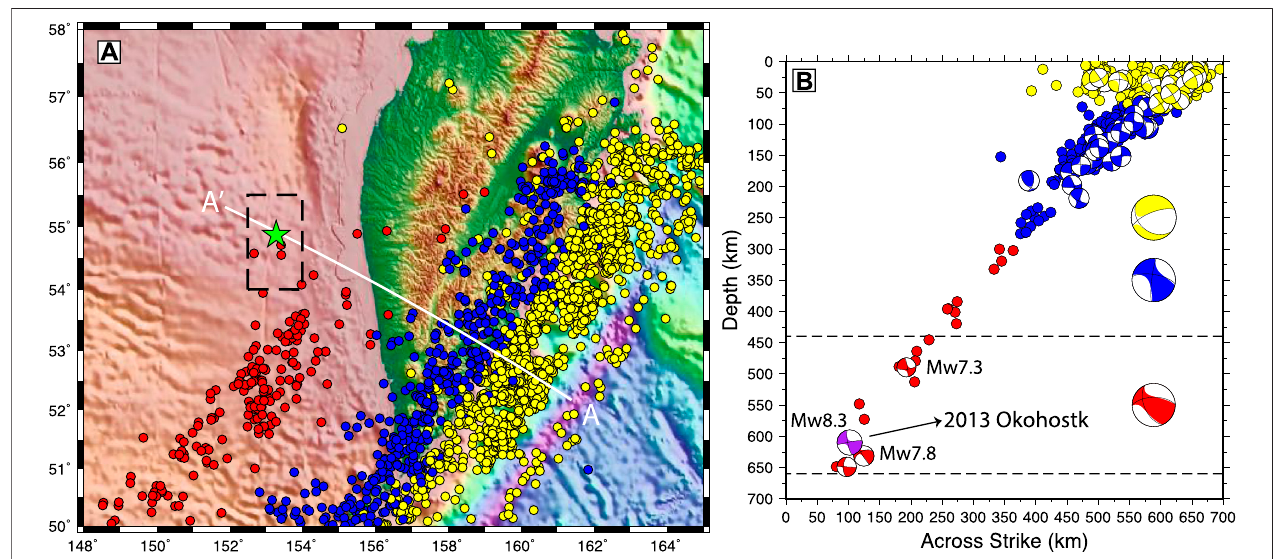
FIGURE 9| Seismicity in North Kamchatkasubduction zone. (A) Seismicity distribution from the EHB Bulletin, ISC (1960 – 2008, http://www.isc.ac.uk/ehbbulletin/ search/bulletin/). The shallow, intermediate, and deep-focus earthquakes are depicted by yellow, blue, and red dots, respectively. Green star indicates the epicenter of the 2013 Okhotsk earthquake. Black dashed frame represents the study region, while white line AA ’ denotes the cross section in Figure 7B . (B) Seismicity of the subducting Paci fi coceanic slabwithin120 kmaround thecross-section AA ’ . Thebeach balls,in asideviewfrom southwest tonortheast, indicate theGCMT focal mechanismsoftheearthquakesalongthecross-sectionAA ’ since1976(http://www.globalcmt.org/CMTsearch.html).Theyarecoloredwithyellow,blue,andredforthe shallow, intermediate, and deep-focus earthquakes, respectively. The focal mechanism of the 2013 Okhotsk earthquake is indicated by a purple beach ball, which has the same P axis as two other deep-focus earthquakes (M w 7.3 and M w 7.8). The three larger beach balls on the right-hand side from top to bottom indicate the normalized, summed focal mechanisms of the shallow, intermediate, and deep-focus earthquakes,